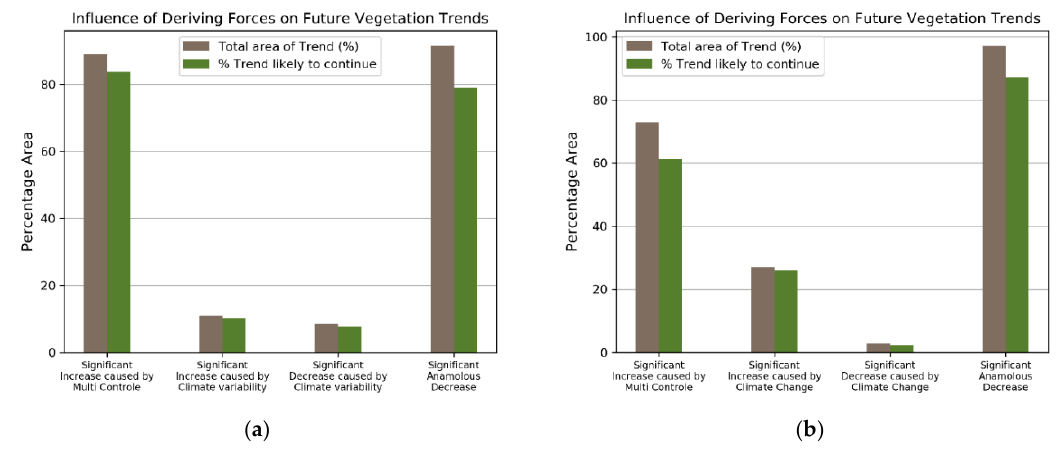
Figure 9. Influence of driving forces on future vegetation trends, ( a ) Annual, and ( b ) Growing Season. On the other hand, during the annual study period, out of total significant decrease in vegetation, 91.48% was significant anomalous decrease, out of which 79.04% is likely to continue in future, which indicates that the 86.40% significant anomalous decrease shows persistent trends. Climate variability caused 8.51% of total significant decrease out of which 7.72% showed consistency that was a 90.69% significant decrease caused by climate variability. Contrary to this, during growing season out of total significant decrease in vegetation, 97.15% was a significant anomalous decrease out of which 87.31% is likely to continue in future, which indicates that the 89.87% significant anomalous decrease shows persistent trends. Furthermore, 2.84% of the total significant decrease was caused by climate variability, out of which 2.25% shows consistency that is 79.41% of significant decrease caused by climate